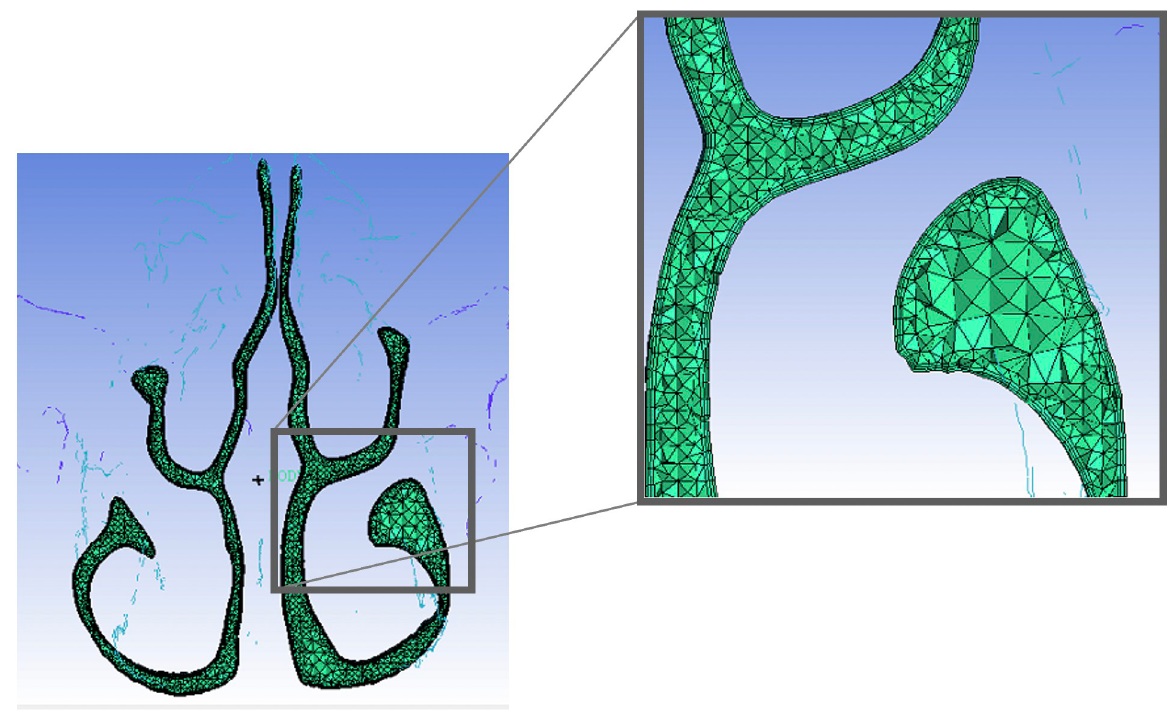
Fig 3. Three-dimensional mesh cross-section of the nasal cavity. The front section of the nasal cavity with a focus on the wall. The unstructured tetrahedral/prism hybrid mesh of the airway model was generated. Three layers of the prism mesh were placed near the wall.